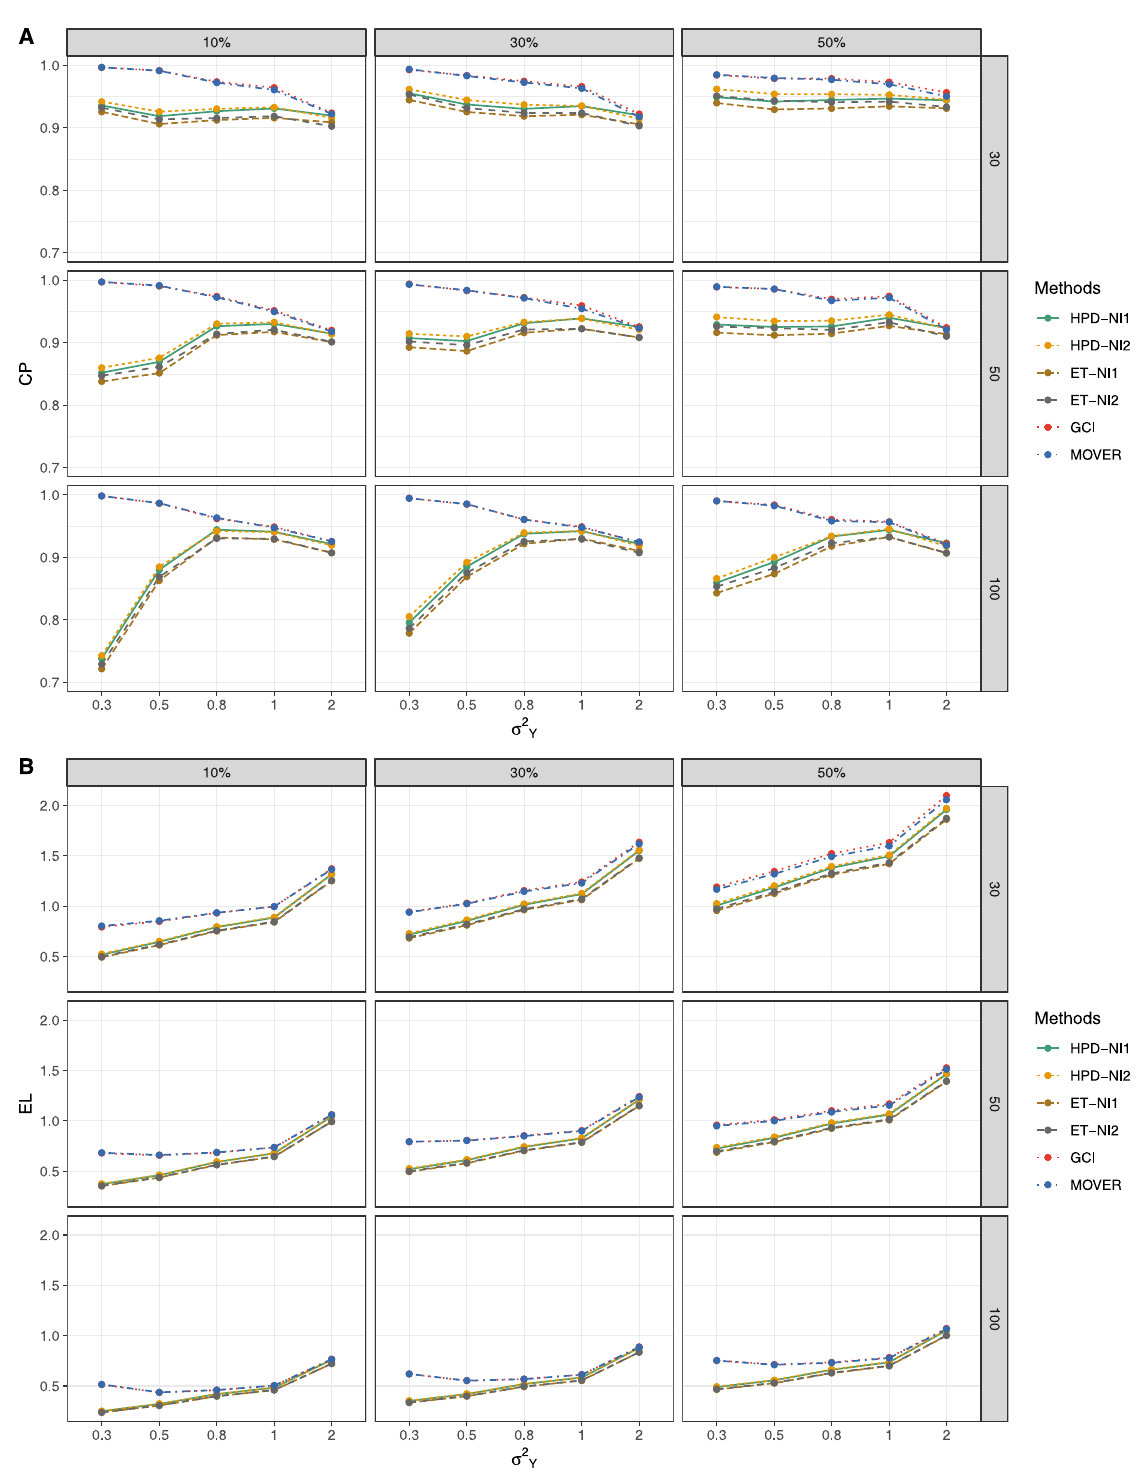
Fig 1. Performance measures of 95%CIs for θ : a = 1 (A) Coverage probabilities and (B) Expected lengths.